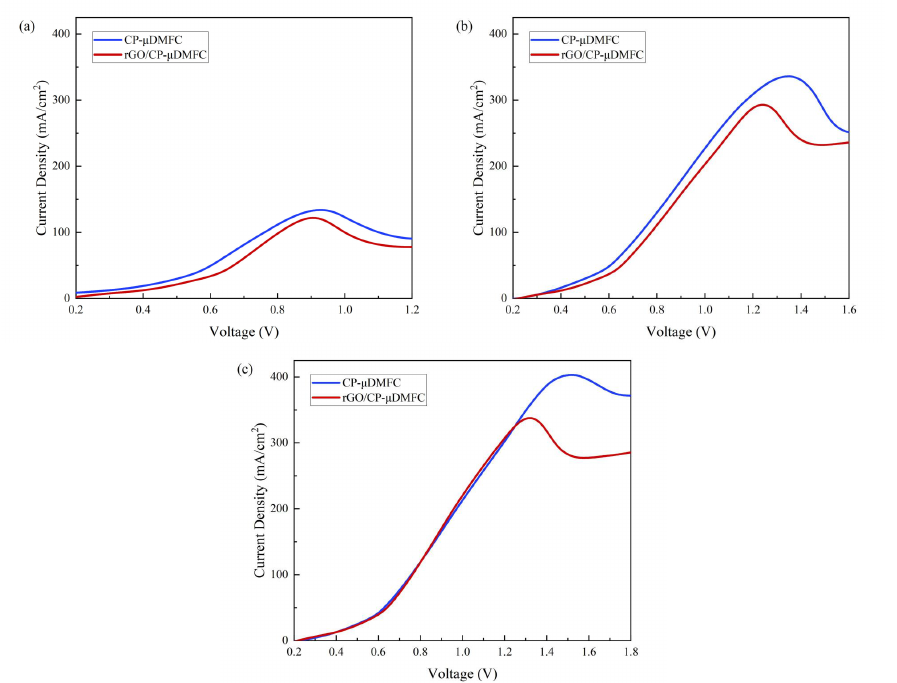
Figure 9. Methanol crossover current densities of the rGO/CP- µ DMFC and the CP- µ DMFC at different methanol concentrations: ( a ) 1 mol/L, ( b ) 3 mol/L, and ( c ) 5 mol/L.